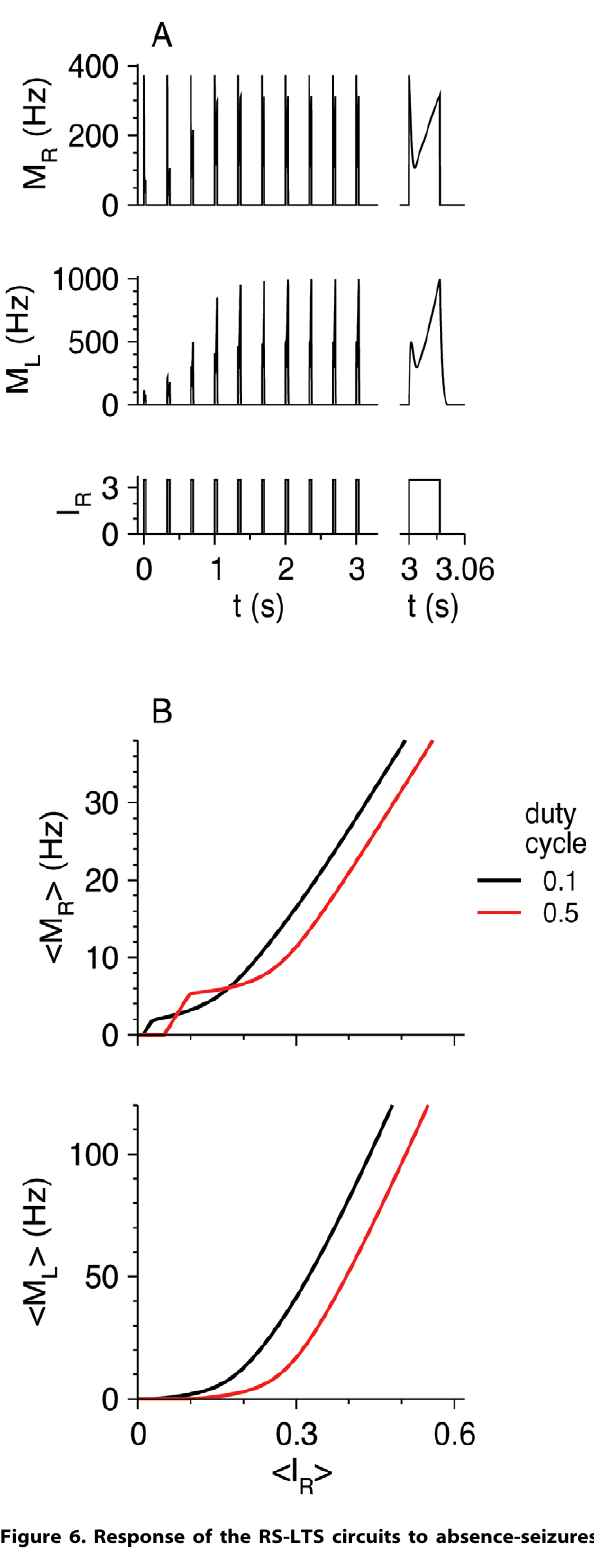
Figure 7. Steady-state response of the RS-FS network to constant inputs to the RS and FS neurons. M R - I R curves (top panel) and M F - I R curves (bottom panel) are plotted for g RF =0 (black), 25 (red) and 50 (green). Additional parameters are: g RR =20, g FR =25, g FF =5, I F =0.35 (independent of I R ).